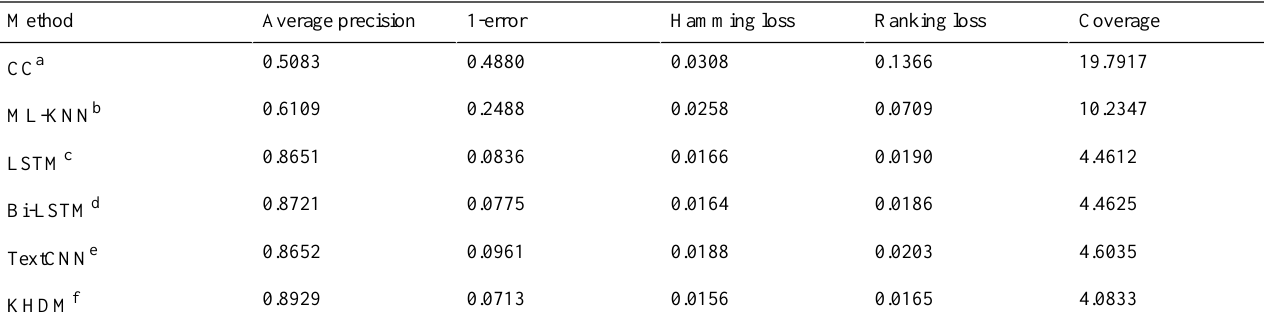
Table 1. Comparative results on Chinese obstetric electronic medical record dataset.